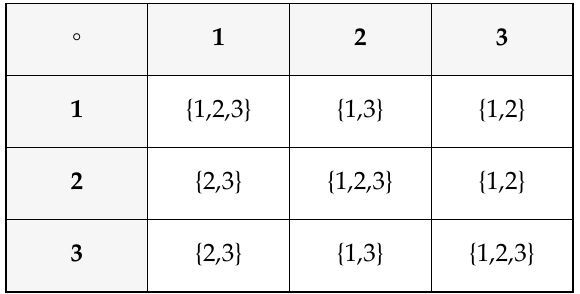
Table 16. The rigid right almost-hypergroup of three elements.